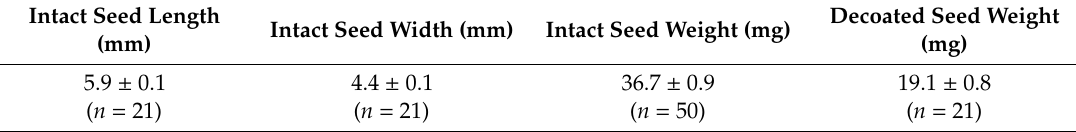
Table 2. Parametric characterization of mature seeds of M. autumnalis . (means ±